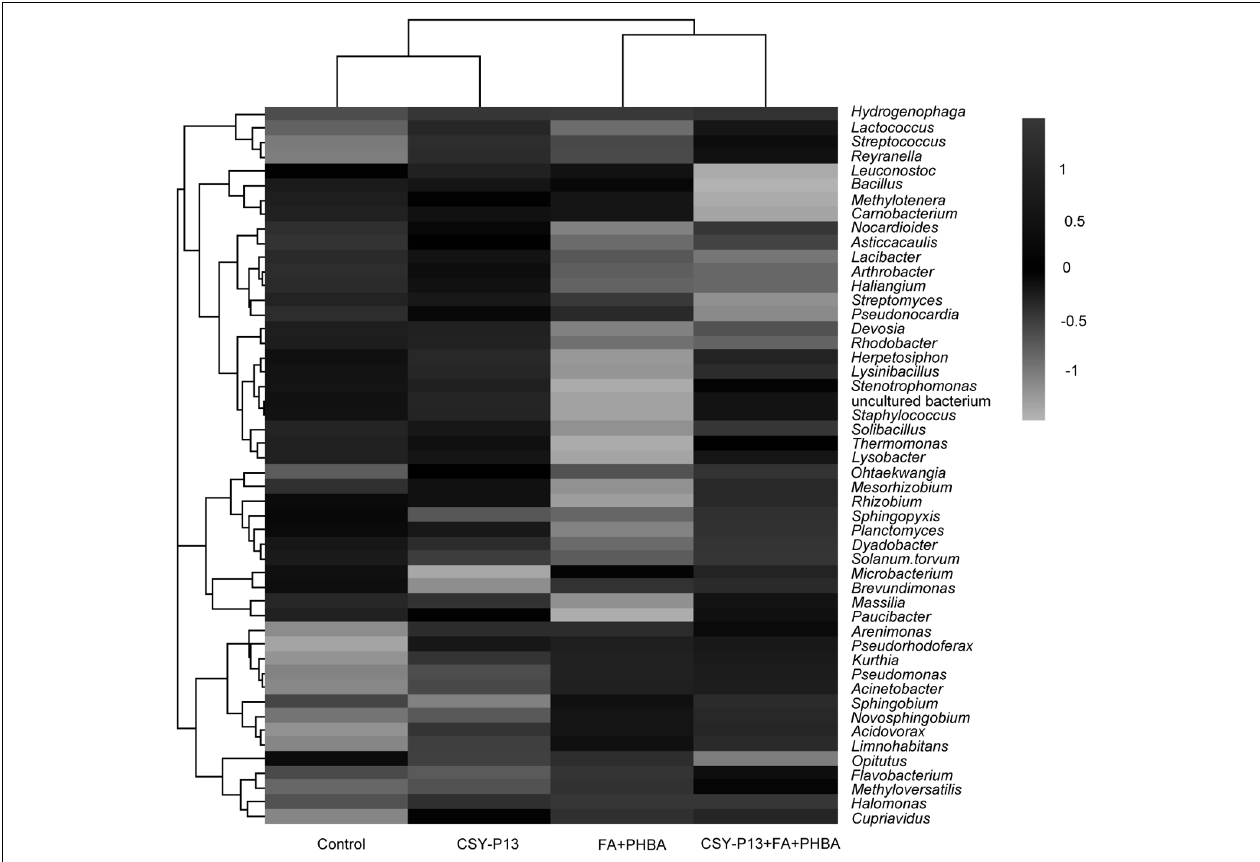
FIGURE 10 | Heatmap showing the relative abundance of the top 50 abundant bacterial genera in rhizospheric soil. Phylogenetic trees are performed using the neighbor-joining method. Shading zones represent the relative abundance of different treatments within each genus. For a certain genus, when the shading intensity of one treatment is between 0 and 1, the abundance value of the genus in this treatment is higher than the mean abundance value of the genus in four treatments; when the shading intensity of one treatment is between 0 and –1, the abundance value of the genus in this treatment is lower than the mean abundance value of the genus in all